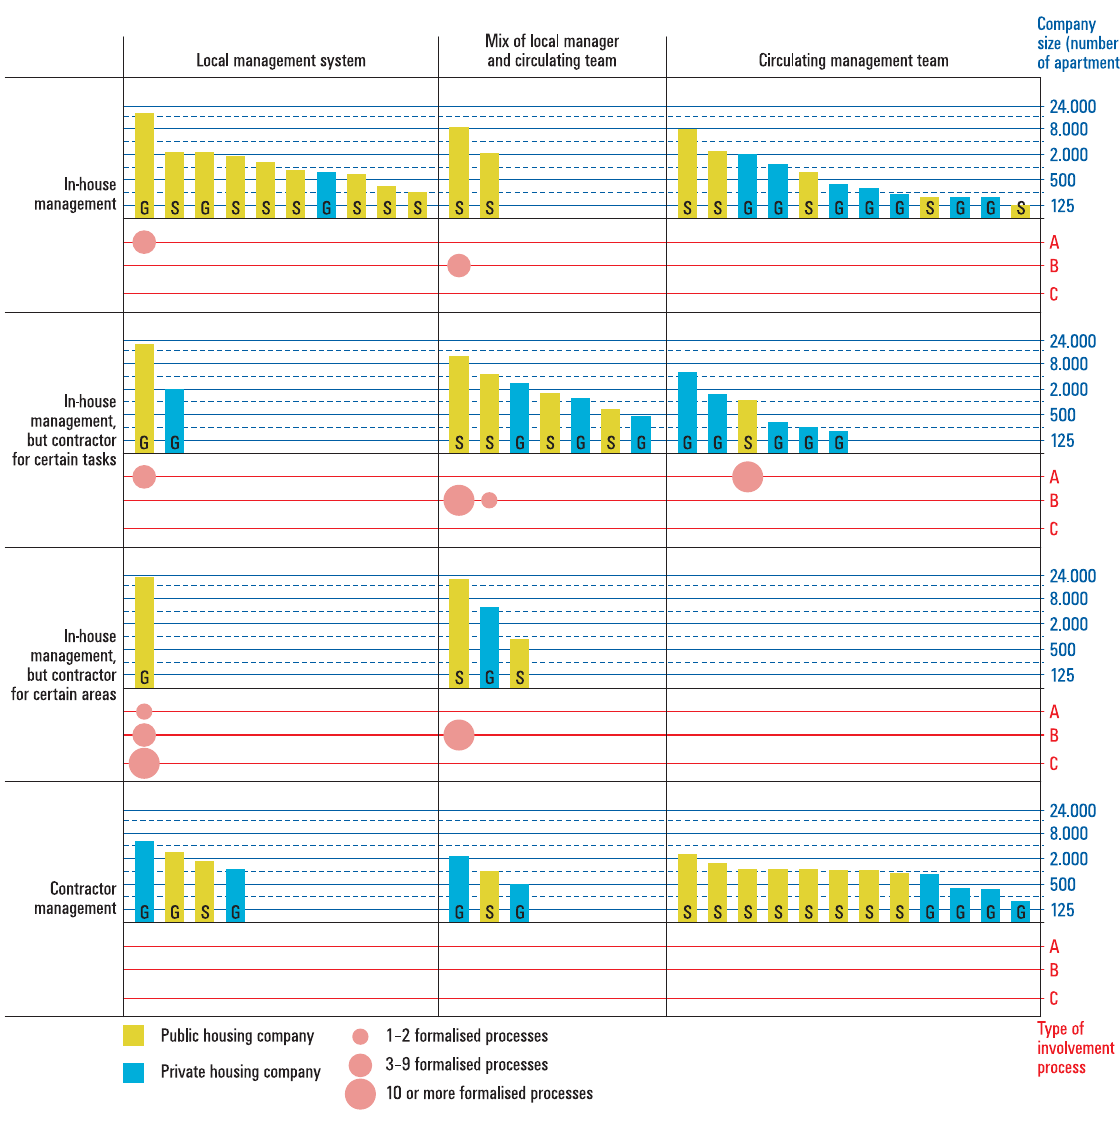
Figure 3. Summary of the number of companies in different categories Bar height indicates the size of each company (logarithmic scale). Bar colour indicates public or private ownership. Letters on bars indicate location (S = Skåne; G = Göteborg). The red circles represent where examples of formalised self-management processes are found. A: Self-management; B: Supervised self- management; C: Garden group (see Castell,